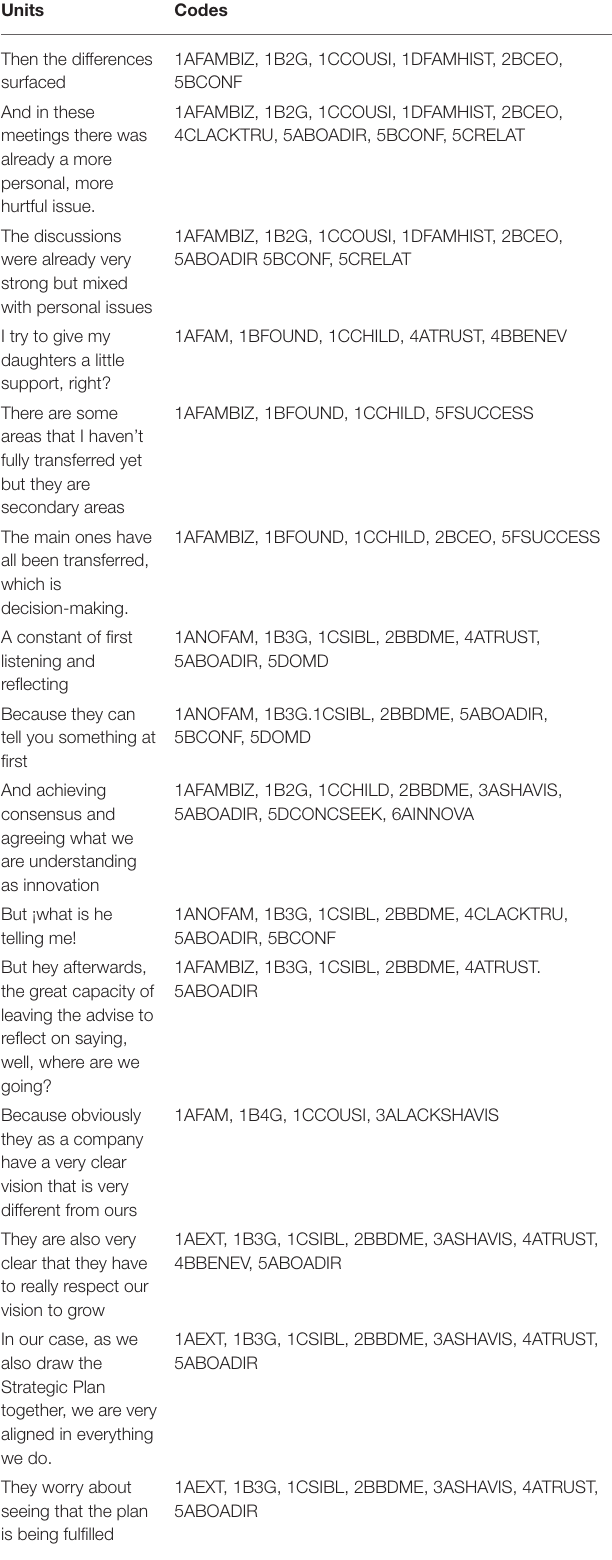
TABLE 4 | Some examples of unitizing and